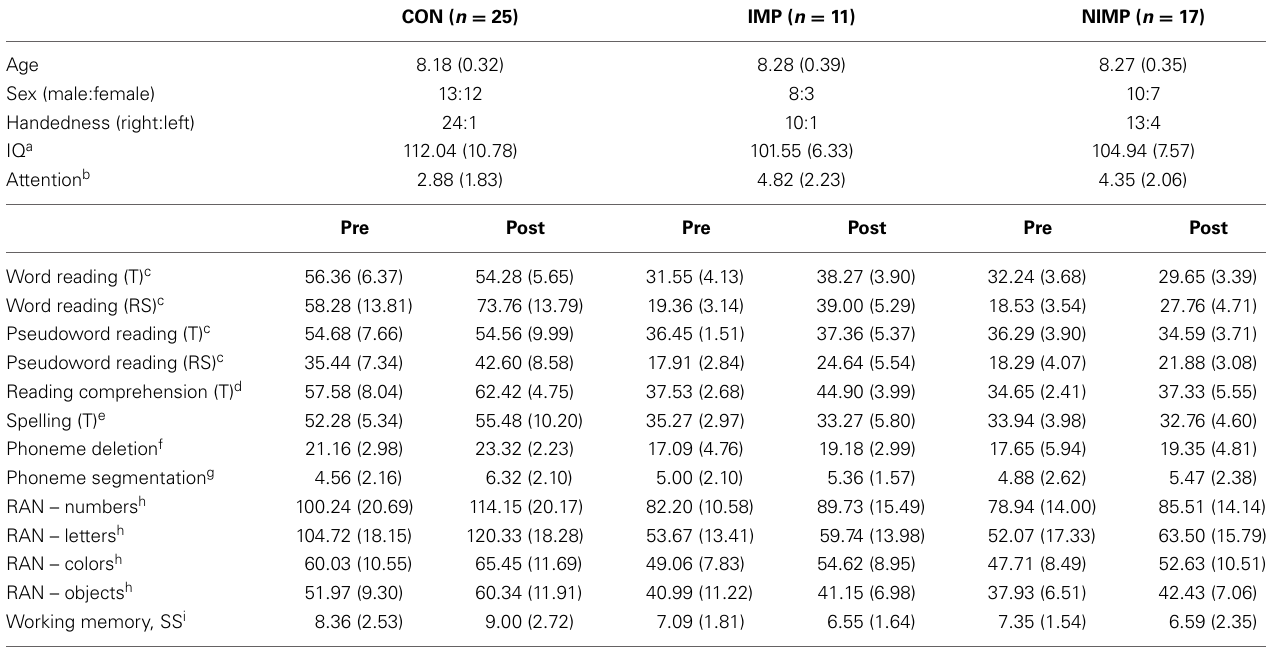
Table 1 | Descriptive statistics of CON, IMP, and